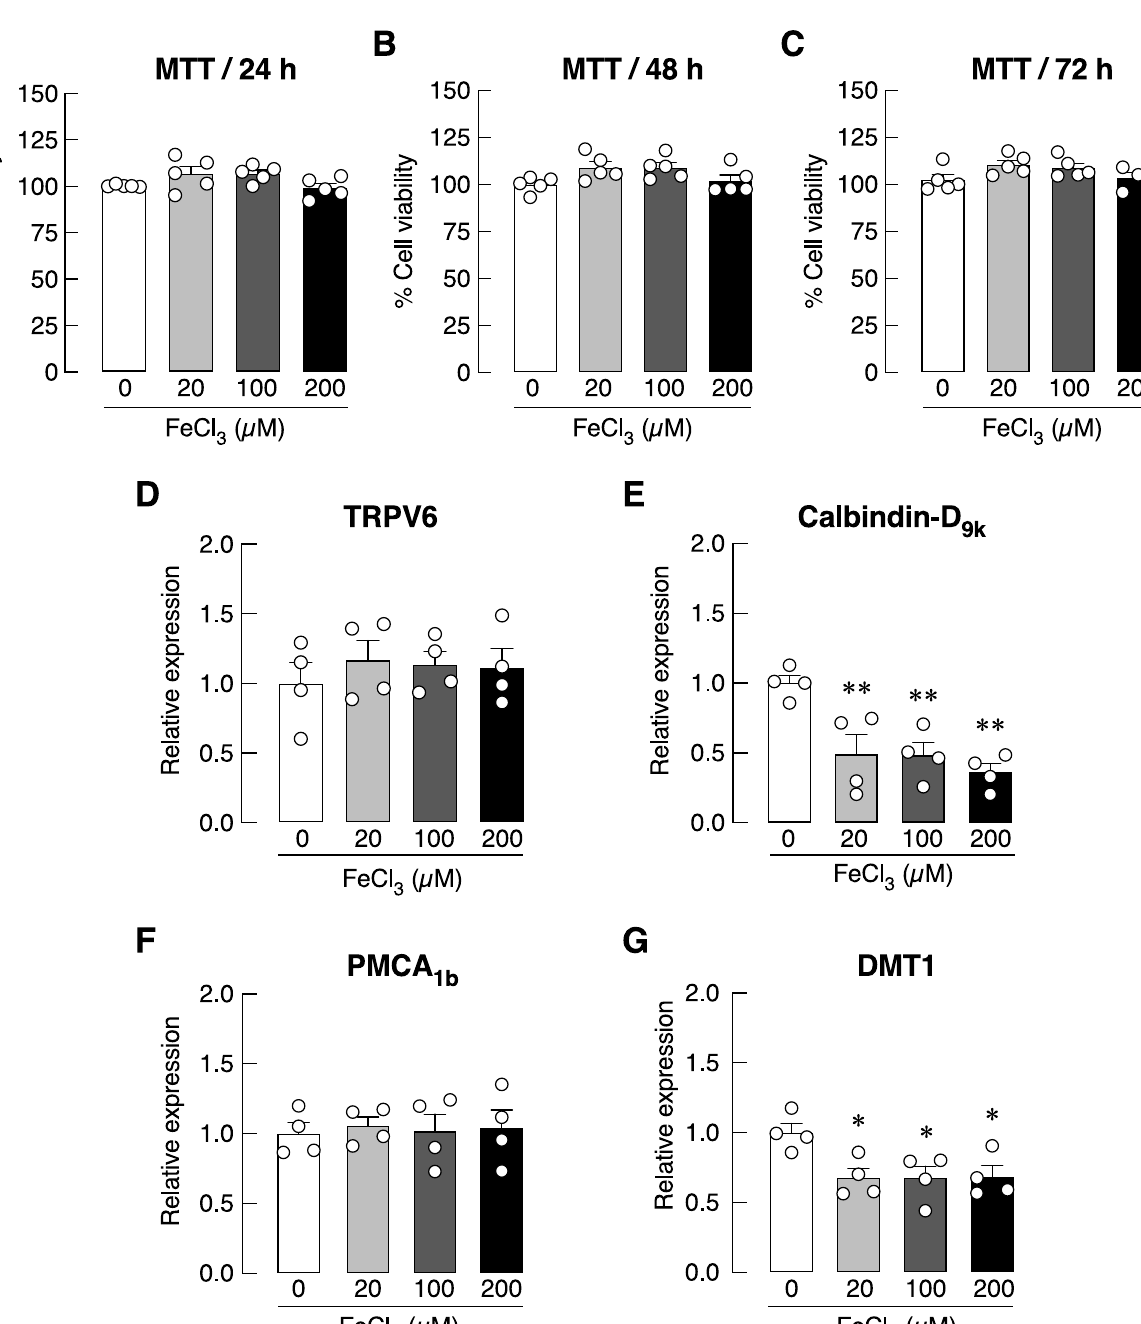
Fig 6. Viability and mRNA expression of calcium transport-related genes and DMT1 gene in Caco-2 cells treated with FeCl 3 . (A–C) Cell viability of Caco-2 cells treated with various concentrations of FeCl 3 (i.e., 0, 20, 100, 200 μ M) for 24, 24 and 72 h. (D–G) mRNA expression of calcium transport-related genes (i.e., TRPV6, calbindin-D 9k , PMCA 1b ), and iron transporter DMT1 gene in Caco-2 cells treated with various concentrations of FeCl 3 (i.e., 0, 20, 100, 200 μ M) for 24 h.